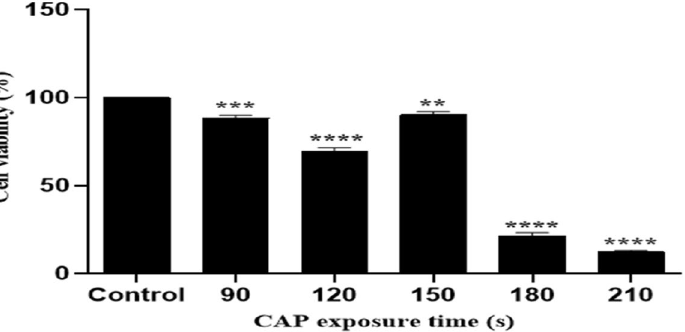
Figure 2. The MTT cell viability assay of CAP treated T. rubrum cells exposed to CAP for 90, 120, 150, 180, and 210 s. The MTT assay was done 24 h after CAP treatment for different CAP exposure times (X-axis) and the percentage of cell viability (Y-axis), determined by colorimetry (density of purple color of formazan) and represented as vertical bars. The error bars show the standard deviation. Asterisks show statistically significant difference with the control group (ANOVA, ** P < 0.01, *** P < 0.001, **** P <